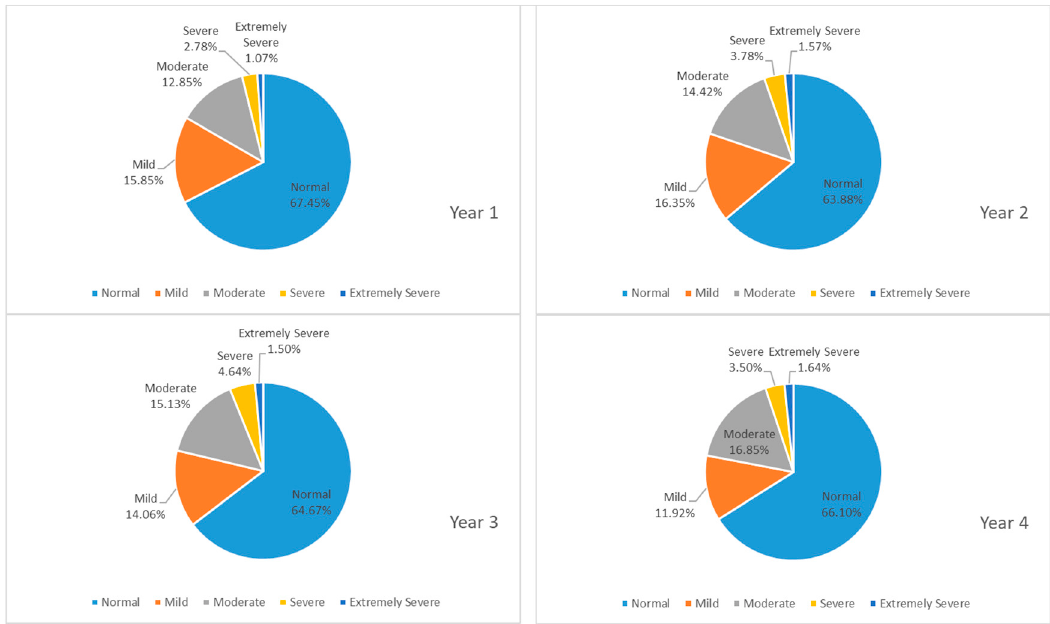
Figure 2. Proportion of participants whose answers on the Depression Anxiety Stress Scales-21 (DASS-21) indicated a normal, mild, moderate, severe or extremely severe amount of depression across years. Int. J. Environ. Res. Public Health 2019 , 16 , x